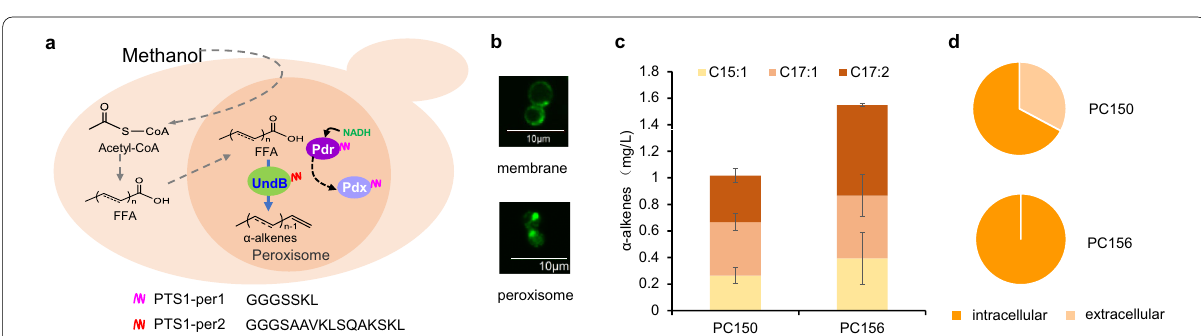
Fig. 4 Peroxisomal compartmentalization improved α-alkenes production in P. pastoris . a Schematic view of the metabolic pathway. b Confocal fluorescence microscopy analysis of PC111 that carried an UndB - eGFP (membrane) or UndB - eGFP - Per2 (peroxisome) fusion gene. c α-Alkenes titers from the engineered strains. C15:1, 1-pentadecene; C17:1, 1-heptadecene; C17:2, 1,8-heptadecadiene. d The distribution of α-alkenes from methanol. All data were represented as the mean s.d. of three ±